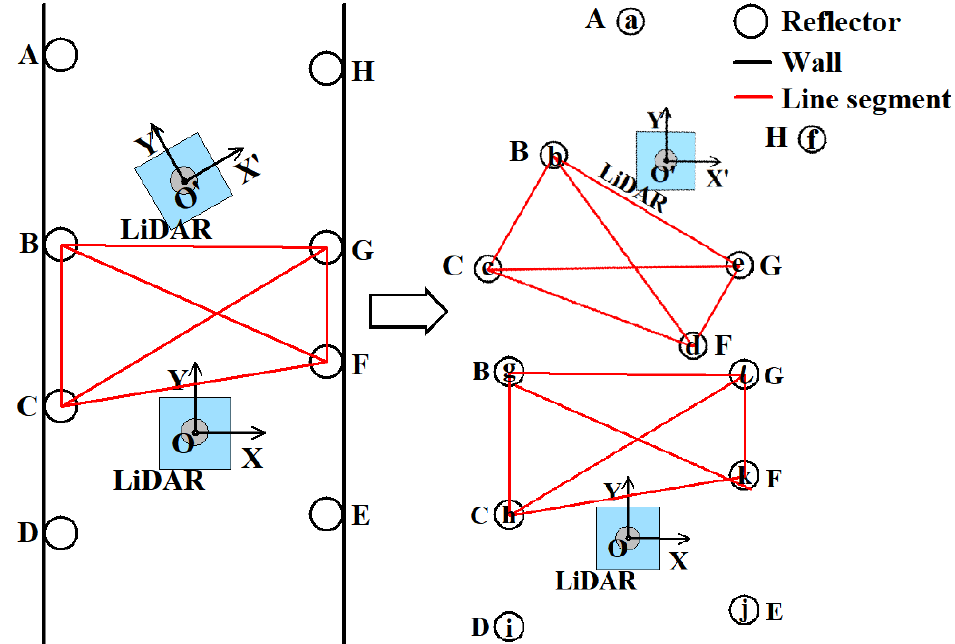
Figure 13. The LiDAR scans reflectors in two positions. Four same reflectors are scanned in both two point cloud frames. Therefore, if correspondences of four reflectors in two frames are known, the pose transformation can be calculated based on their coordinates.